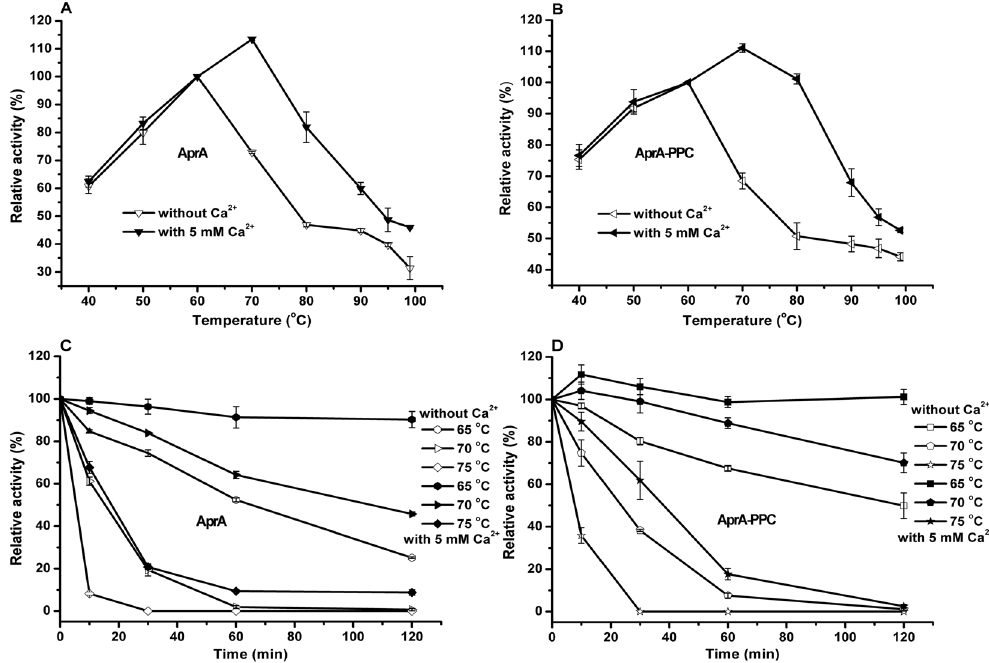
Figure 6. Effects of temperature on AprA and AprA-PPC activity and stability with or without Ca 2 + . ( A ) The optimal temperature for AprA activity; ( B ) The optimal temperature for AprA-PPC activity; ( C ) Thermal stability of AprA; ( D ) Thermal stability of AprA-PPC. Filled symbols indicated assay with 5 mM Ca 2 + , whereas the empty symbols indicated assay without Ca 2 + . The thermal stability was determined by assaying the residual activity of enzyme under standard condition after incubation at different temperature for various time intervals. The measurements were performed in three independent experiments. Error bars represent standard